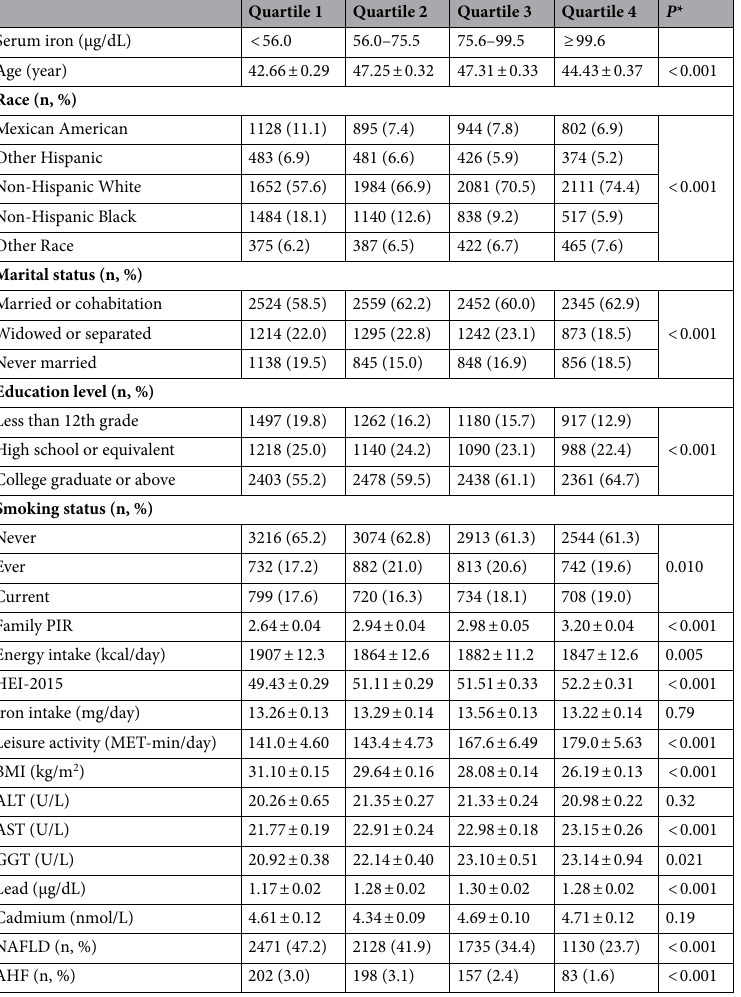
Table 2. Basic characteristics of participants according to quartiles of serum iron in females. Data were presented as survey weighted mean ± standard error for continuous variables and n (%) for categorical variables. AHF advanced hepatic fibrosis, ALT alanine transaminase, AST aspartate aminotransferase, BMI body mass index, GGT gamma glutamyl transferase, HEI healthy eating index, MET metabolic equivalent of task (MET-min/day), NAFLD non-alcoholic fatty liver disease, PIR poverty income ratio. *Unadjusted P values.